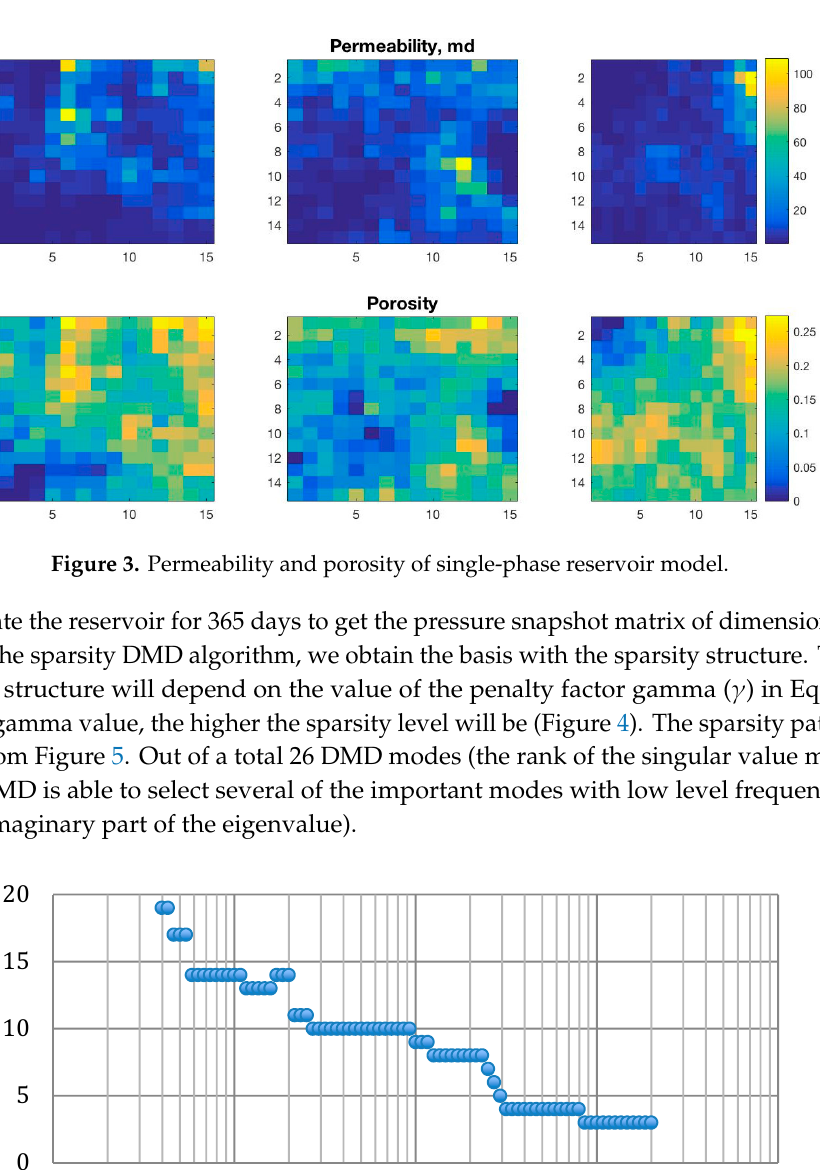
Figure 4. Number of sparsity promoting dynamic mode decomposition (DMD) modes changes with penalty factor gamma.